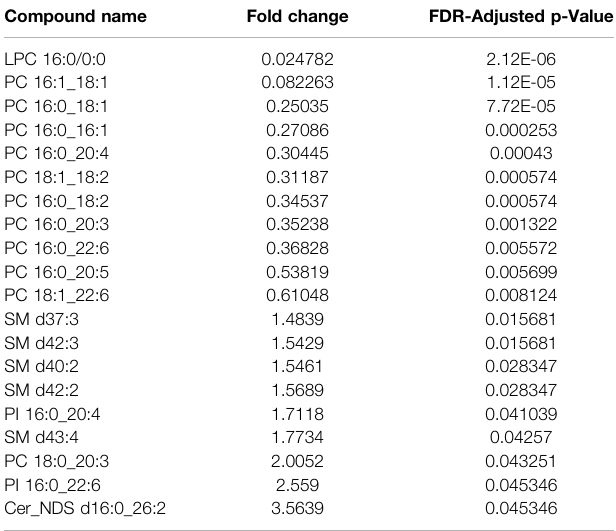
TABLE 1 | Relative fold-change (PF/WP) and signi fi cance of lipids recovered from Para fi lm ™ (PF) dried plasma spots compared to wet plasma (WP). Signi fi cance testing was conducted using a One-Way-ANOVA, Tukey ’ s post-hoc withBonferroni-HochbergFDRcorrectionofp-values(signi fi canceatFDR <